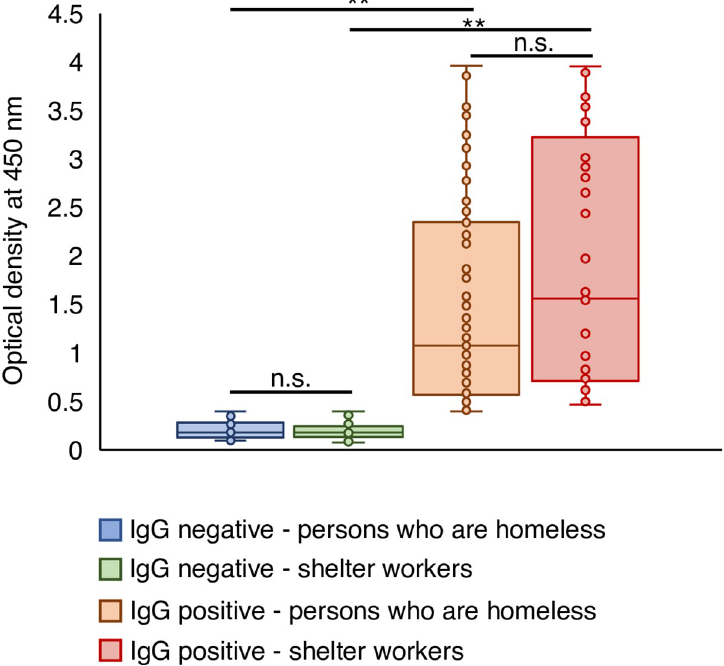
Fig 2. Optical density at 450 nm obtained for the ELISA assay used to detected anti-SARS-CoV-2 IgG in persons who are homeless (n = 203) and shelter workers (n = 87) attending the Community Center of S ã o Martinho de Lima, Mooca subregion, S ã o Paulo, Brazil. ELISA assay was performed as described in materials and methods. �� p � 0.05 (Positive IgG–individuals who are homeless versus shelter workers: p = 0.025), n.s.: not significant (Negative IgG–individuals who are homeless versus shelter workers: p = 0.901). Statistical analysis was performed using the Mann-Whitney test.